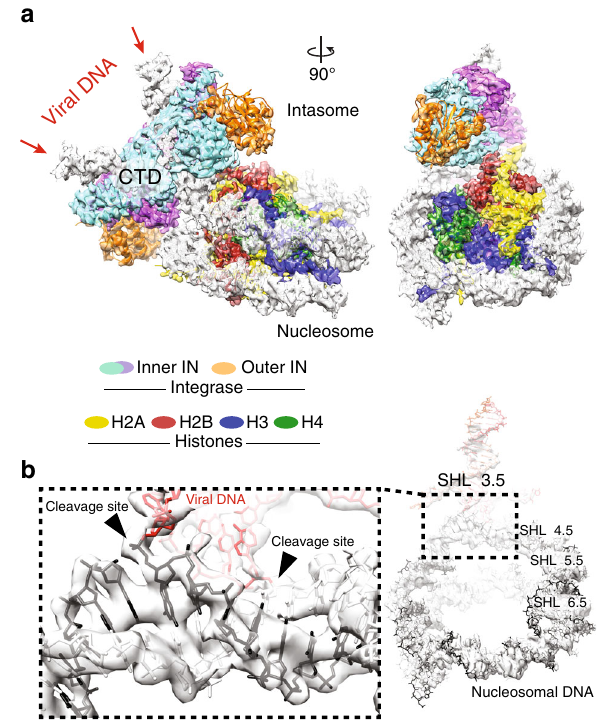
Fig. 1 Intasome-NCP strand-transfer complex visualised by cryo-EM. a 3.9- Å resolution structure of the post-catalytic intasome – NCP complex. IN means intasome, CTD means C-terminal domain. b Covalently linked viral (red) and nucleosomal (black) DNA. Integration occurred at the super- helical location (SHL) location